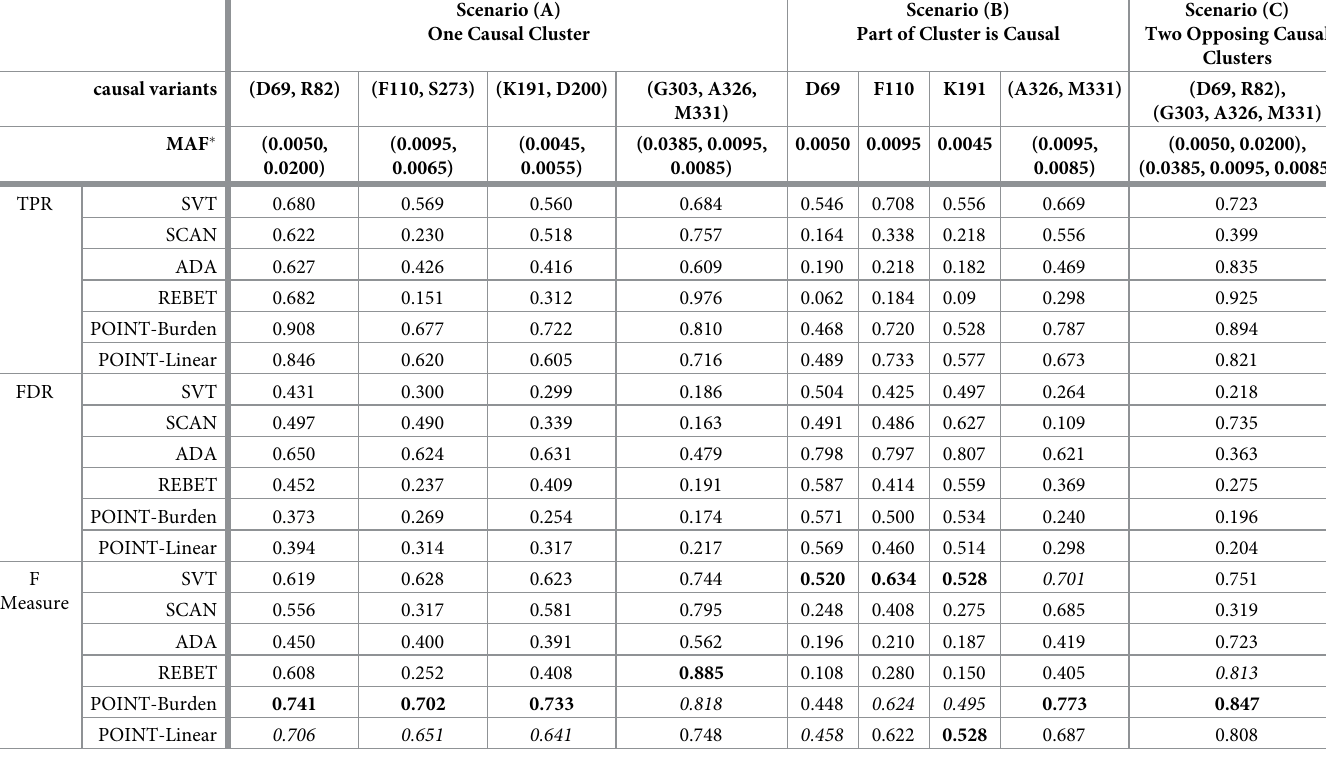
Table 3. Selection performance of binary trait simulation with n = 2000 subjects. Selection performance for single variant test (SVT), scan statistic (SCAN), ADA, REBET, POINT test using local burden kernel (POINT-Burden), and POINT test using local linear kernel (POINT-Linear). The best performed methods (based on the composite F-measure) are shown in bold and the second best are shown in italic